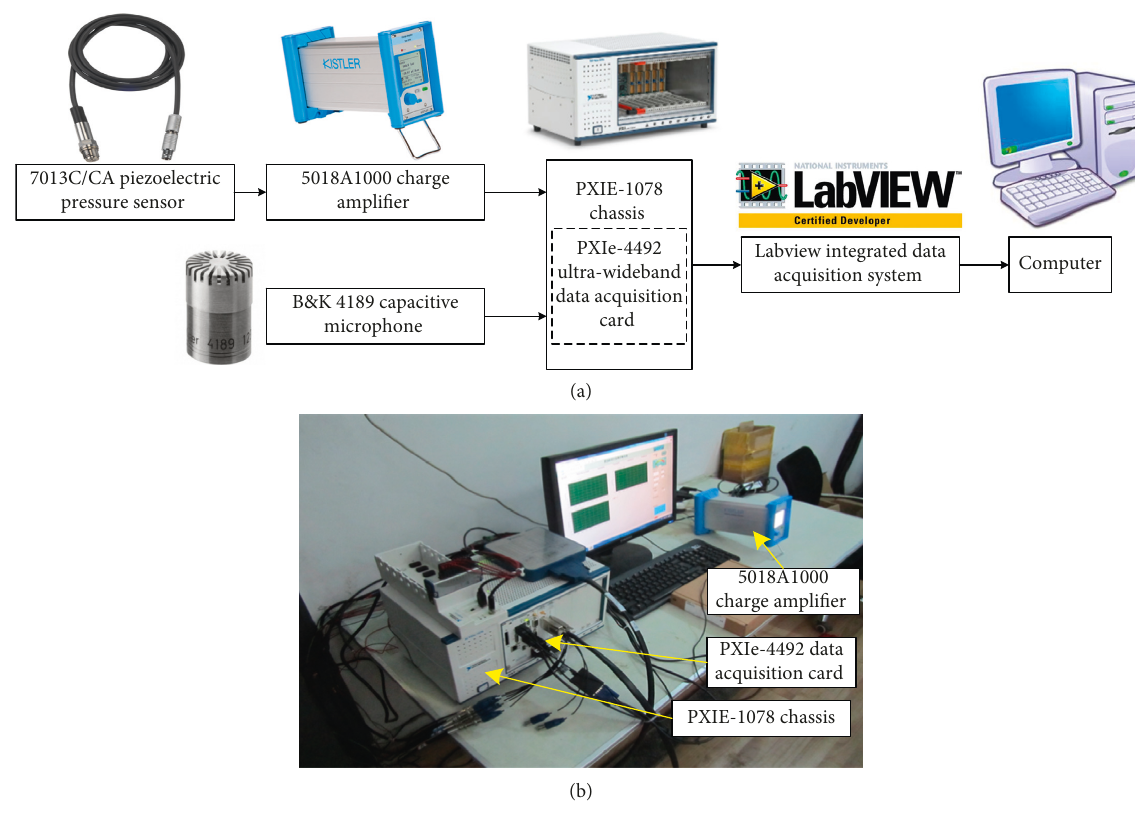
Figure 5: Test equipment. (a) Test system and (b) test site.